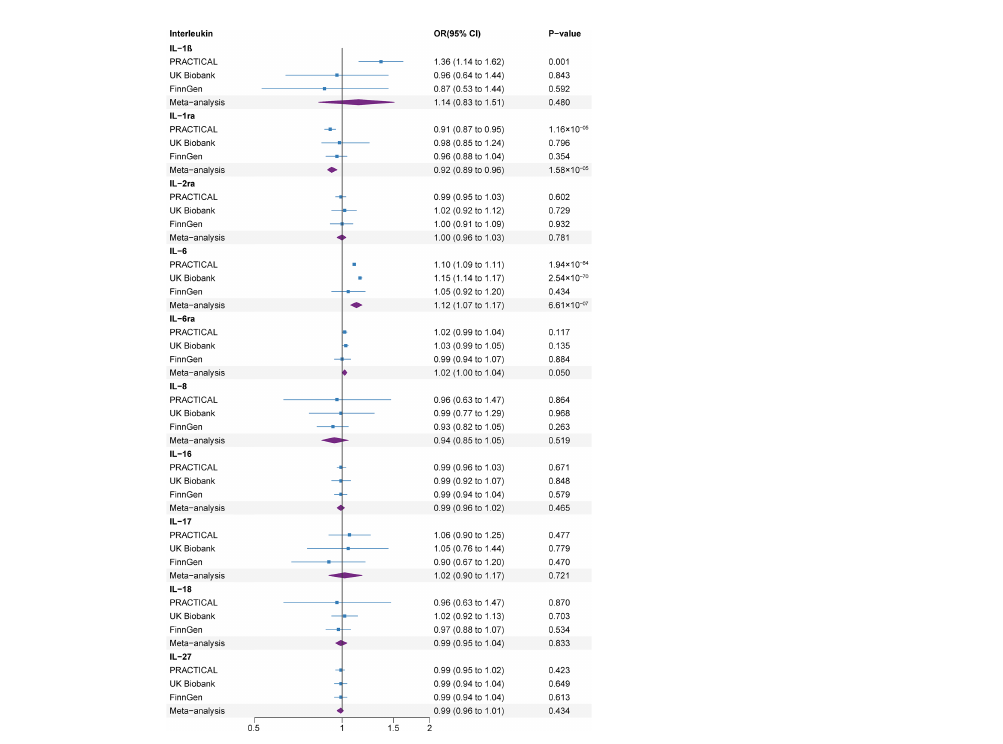
FIGURE 3 Associations of genetically predicted circulating interleukin levels with rheumatoid arthritis. CI, con fi dence interval; IL, interleukin; IL-1b, IL-1 beta; IL-1ra, IL-1 receptor antagonist; IL-2ra, IL-2 receptor alpha subunit; IL-6ra, IL-6 receptor subunit alpha; OR, odds